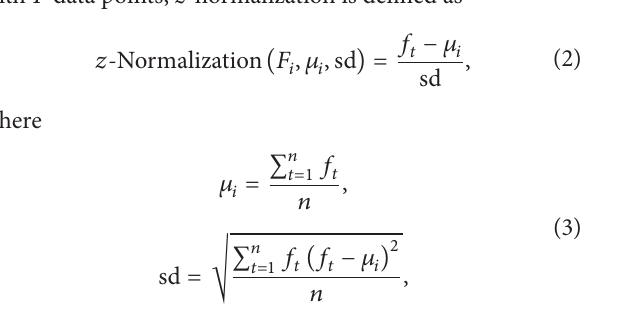
Figure 3: Reasoning behind the use of DTW in calculating similar- ity in shape between the prototypes of subclusters in the second step of